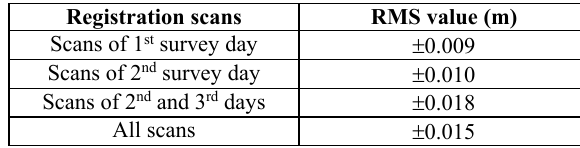
Table 1. RMS values of the registration